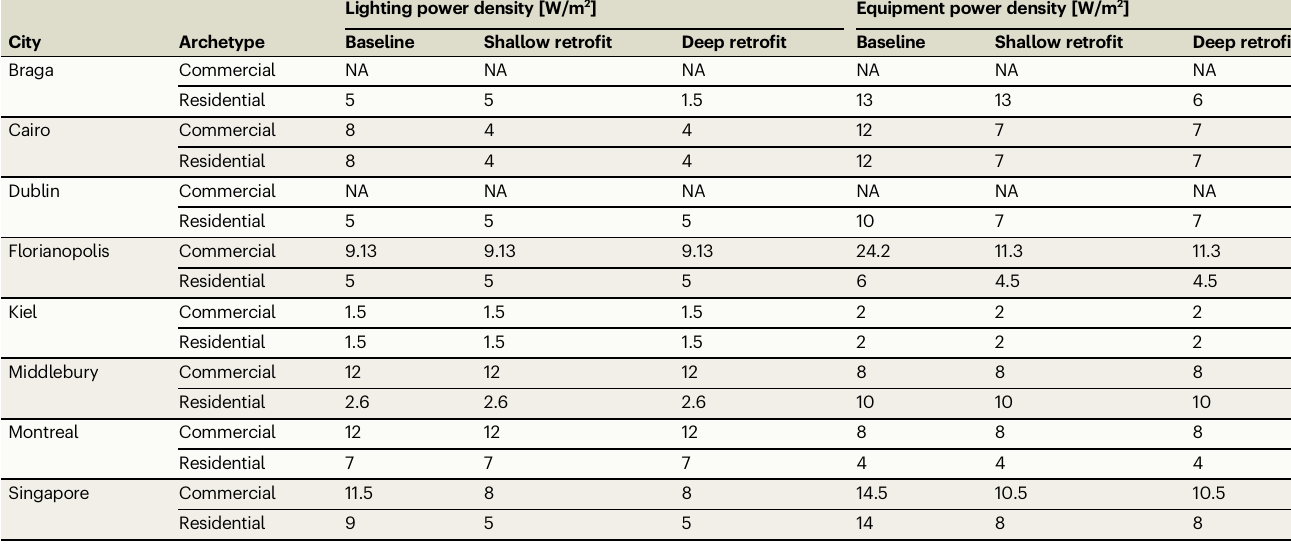
Table 4 | Lighting power densities and equipment loads for the baseline, shallow and deep retro fi t building simulation templates